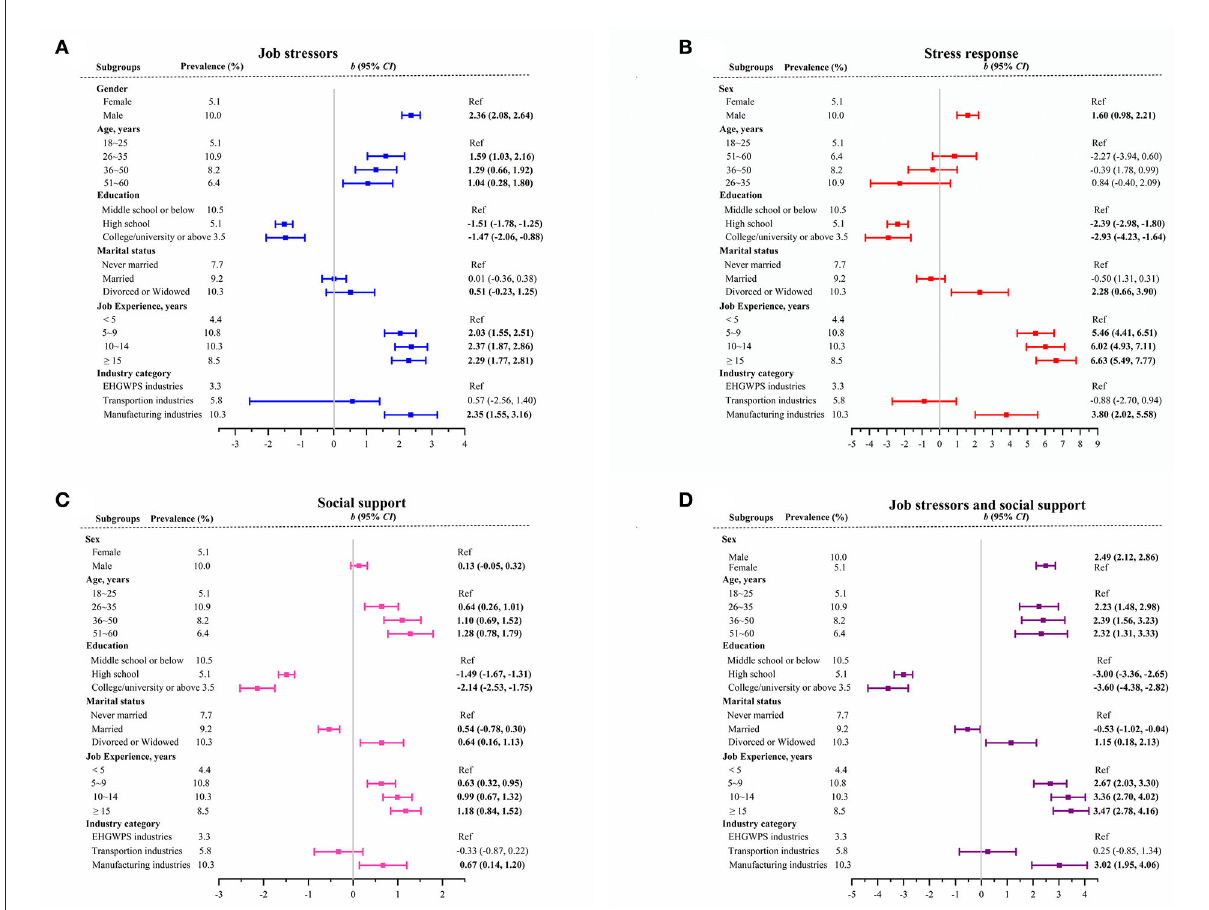
FIGURE1 (A–D) Multiple linear regression random intercept model, of high occupational stress